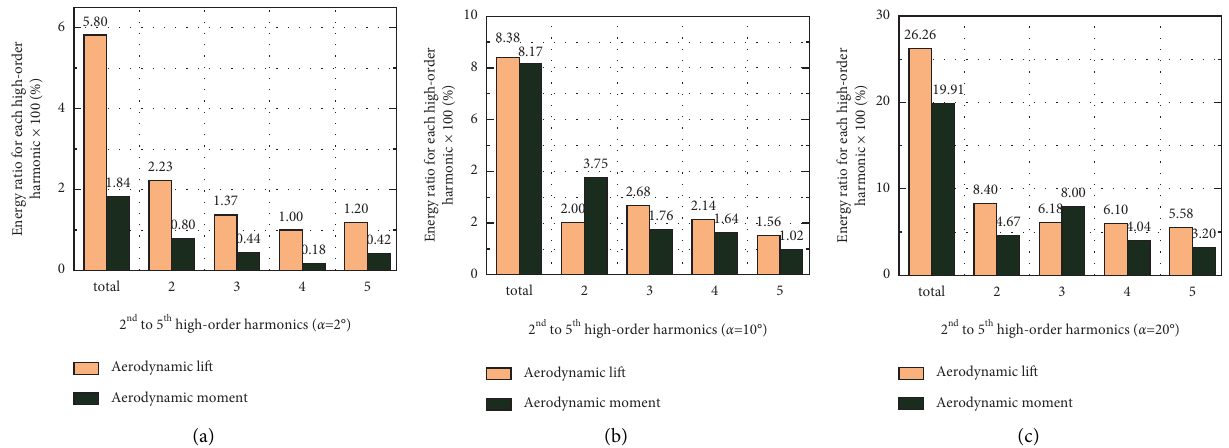
Figure 14: Proportion of high-order harmonics under different torsional amplitude vibrations of the single frequency.